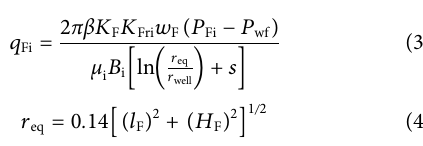
where β is unit conversion factor; w F is the width of a fracture segment, m; P wf is the bottom hole pressure, MPa; r eq is the effective radius, m; r well is the wellbore radius, m; s is the skin factor. For multi-cluster fracturing, the sum of fl ow rates into all fracture segments that intersect the well trajectory must be equal to the fl uid injection rate in the wellbore. Therefore, the internal boundary condition is